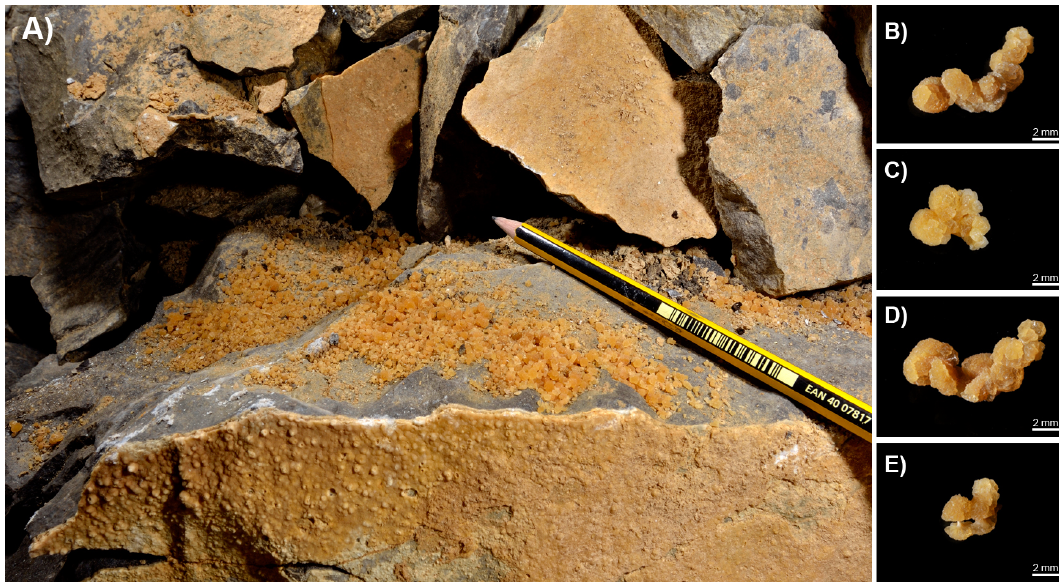
Fig. 2. Coarse crystalline cryogenic cave carbonate (CCC coarse ) observed in Leclanch´e Cave. The loose calcite crystal aggregates occur on the surface of cryoclasts, suggesting recent deposition. Calcite crusts coat several rock fragments, suggesting an earlier phase of vadose speleothem deposition under non-freezing conditions. Individual CCC aggregates, depicted on the right side, have spherical shapes and are amber-coloured. Photographs courtesy of R.